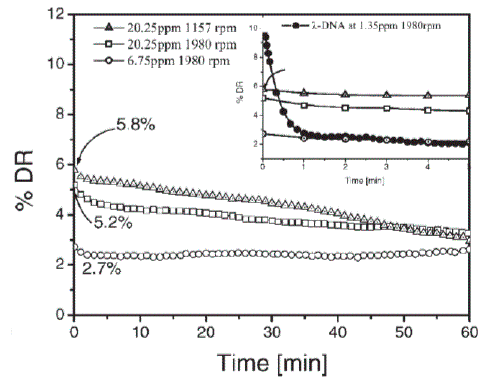
Figure 9. Comparison of the drag reducing characteristics of calf thymus DNA (CT-DNA) with those of linear high molecular weight synthetic polyacrylamide (PAAM) (polydisperse) and monodisperse λ -DNA, reprinted with permission from [83]. Copyright Elsevier, 2005.